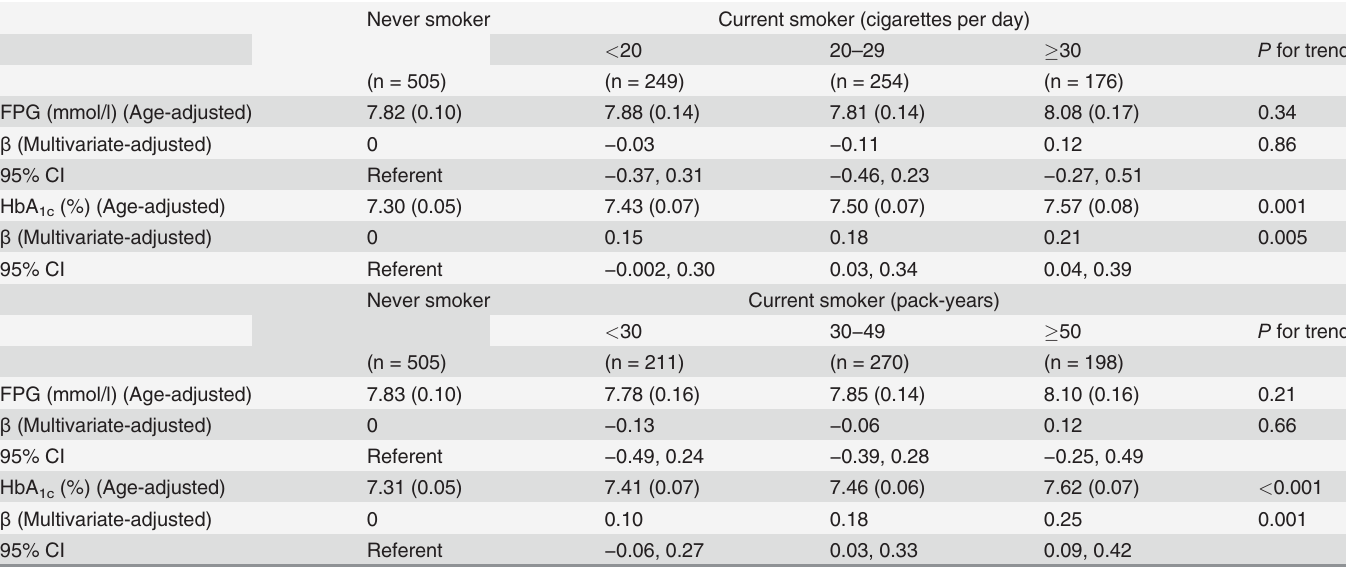
Table 3. Age-adjusted mean values and multivariate-adjusted partial regression coefficients (95% CIs) of FPG and HbA 1c according to the amount of smoking. Never